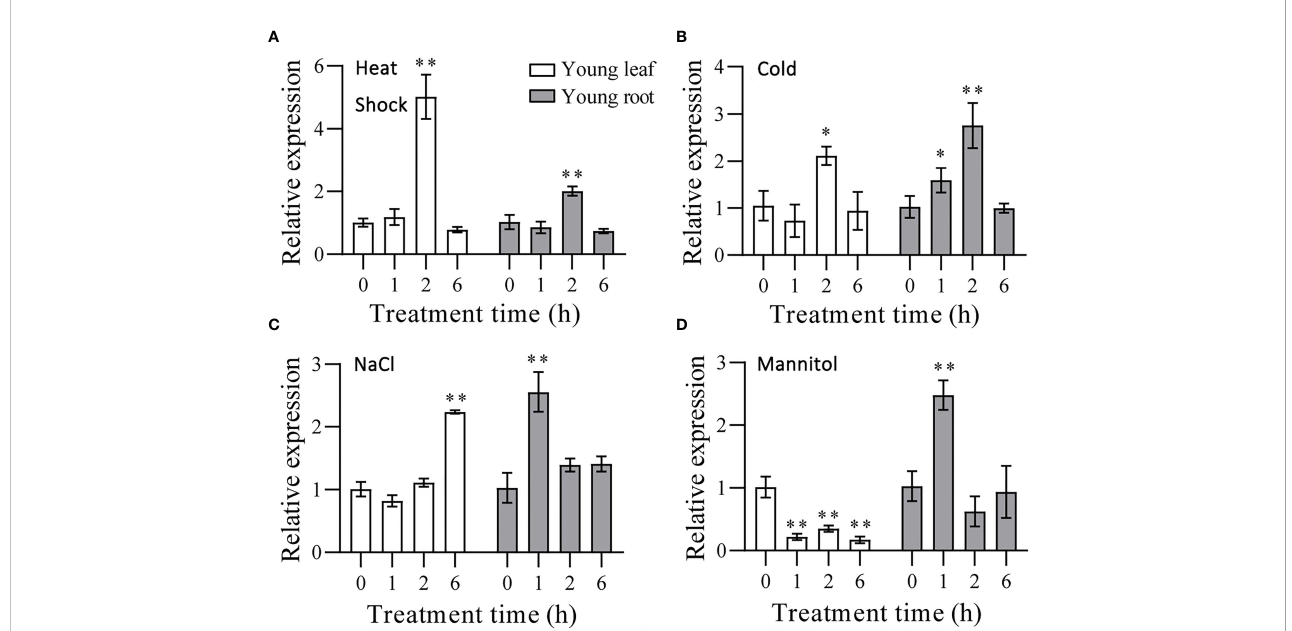
FIGURE 6 Expression levels of TaHSFB4-2B in wheat seedlings young leaf and young root of wheat under abiotic stress. (A) Wheat seedlings growing for 14 d after germination were treated under high temperature (37°C). (B) Cold stress (4°C). (C) NaCl induced stress (200 mM NaCl). (D) mannitol-induced dehydration stimulating drought stress (300 mM mannitol). Young leaf and young root were sampled after 0, 1, 2, and 6h of each treatment and the transcription levels of TaHSFB4-2B were quanti fi ed by RT-qPCR. The transcription level of TaHSFB4-2B was normalized with TaACTIN . Values are Mean ± SD, n=3. * P < 0.05 and ** P < 0.01 (Student ’ s